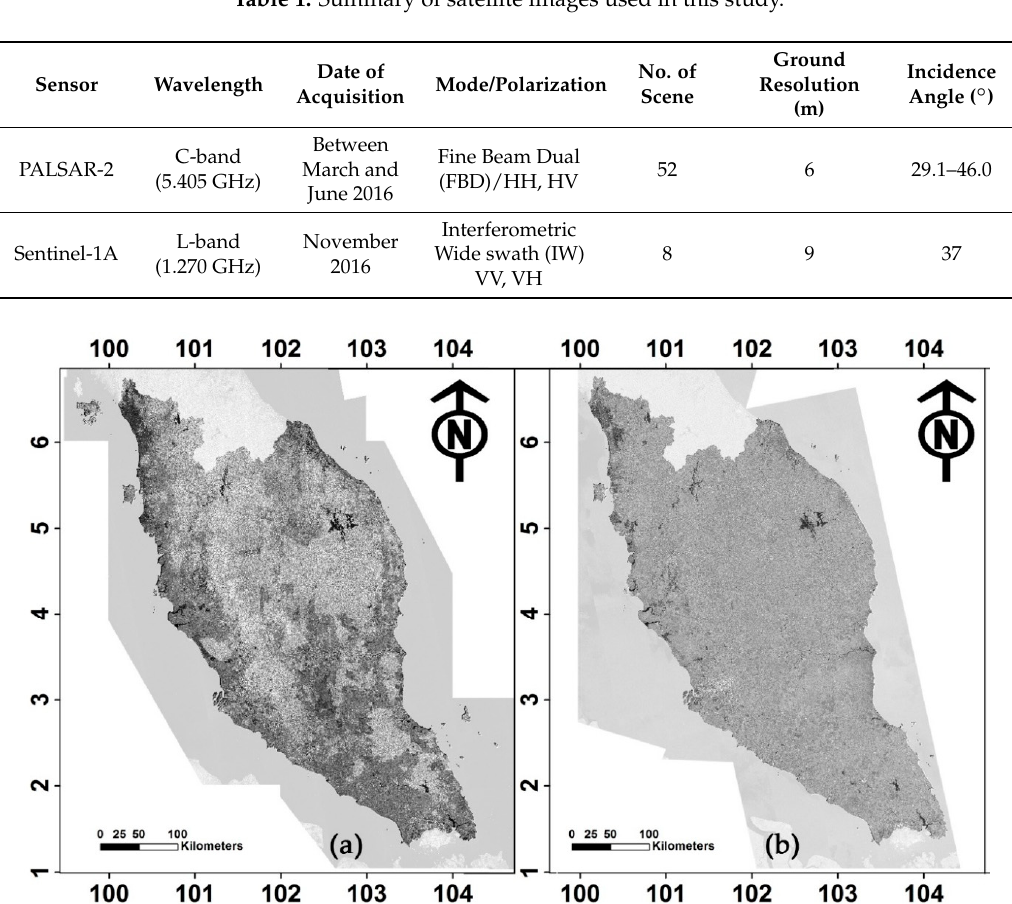
Figure 2. Mosaics of ( a ) PALSAR-2 and ( b ) Sentinel-1A over Peninsular Malaysia, displayed HV and VH polarizations, respectively.